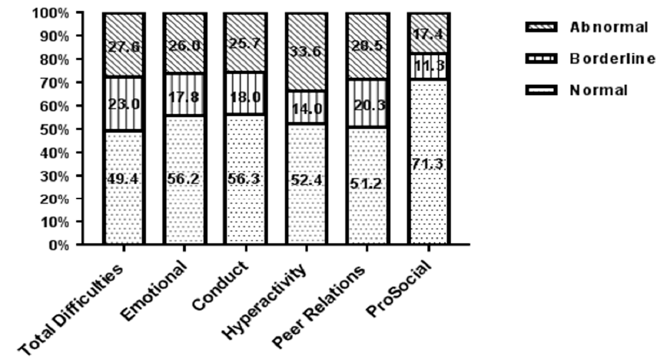
Figure 1. Strength and Di ffi culties Questionnaire (SDQ) banded scores for Hunan three- to five-year-old LBC in 2015.